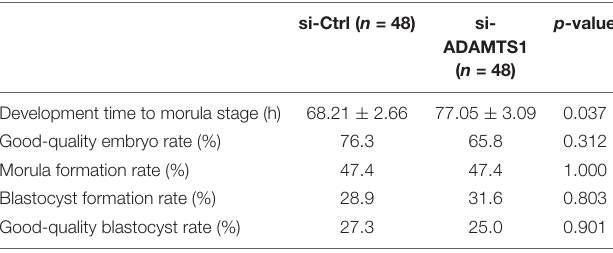
TABLE 3 | Studies of embryo development after silencing of ADAMTS1. si-Ctrl ( n = 48) si-